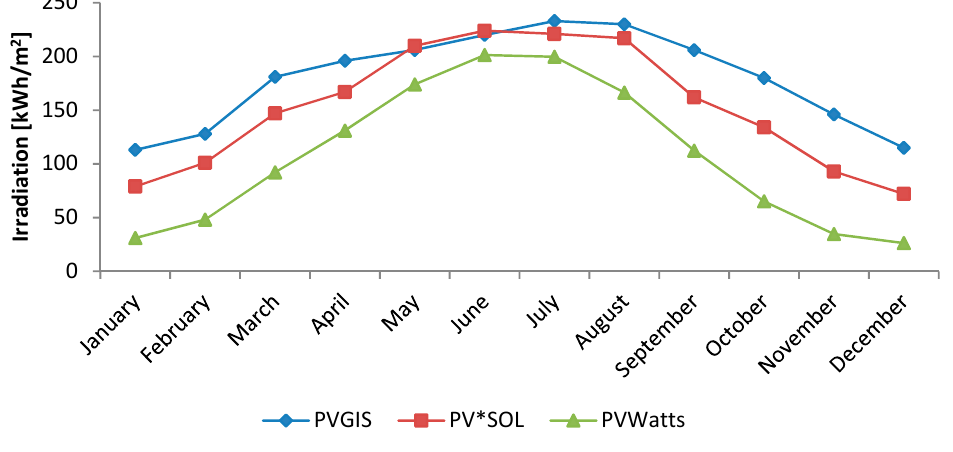
Environments 2019 , 6 , 47 Figure 10. Monthly variation of solar irradiation for Girne. Figure 10. Monthly variation of solar irradiation for Girne. Figure 10. Monthly variation of solar irradiation for Girne.